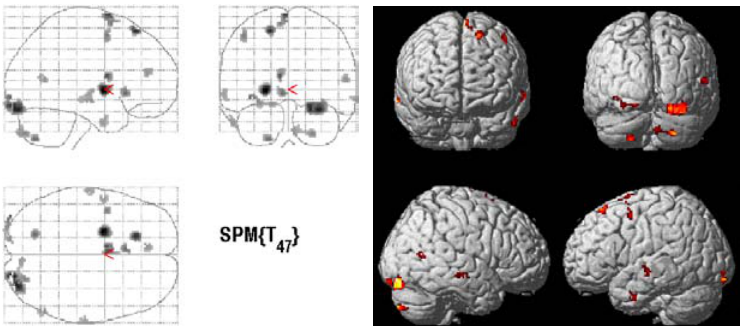
Figure 4: SPM { t } of right medial frontal gyrus maps showing statistically significant differences in functional connectivity between patients with early-onset schizophrenia and healthy controls during resting state. The statistical map was thresholded at P < 0.001 (uncorrected) and cluster size of at least 160 mm 3 .